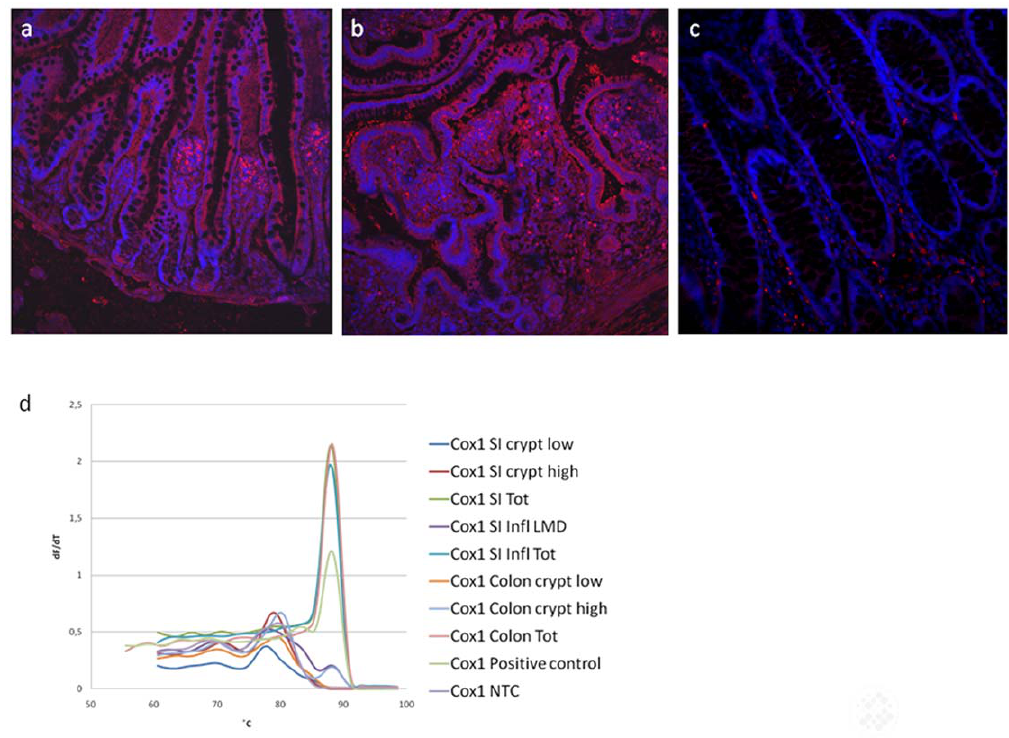
Figure 6. Identification of COX1 in normal and inflamed human intestine. Paraffin sections were prepared for immunohistochemical analysis with anti-COX1 antibodies and the nuclei were stained with Hoechst 33342, a) Normal human small intestine showing positive COX1 cells in lamina propria, b) Human small intestine from patients with untreated celiac disease showing positive COX1 cells in lamina propria, c) Normal human colon showing positive COX1 cells in lamina propria, d) Cells from the different populations described above were dissected by LMD from normal human small intestine and colon, and inflamed small intestinal tissue. RNA were isolated from the dissected cells and analyzed by RT-PCR for the expression of COX1. Amplifications of the COX1 PCR products were verified by the correct melting temperature.